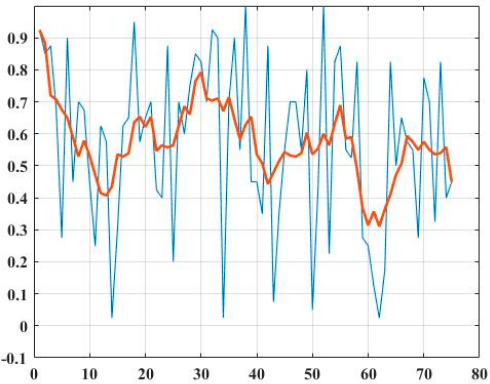
Figure 7. A digitally averaged representation of Mishakat al-Anwar chunks.